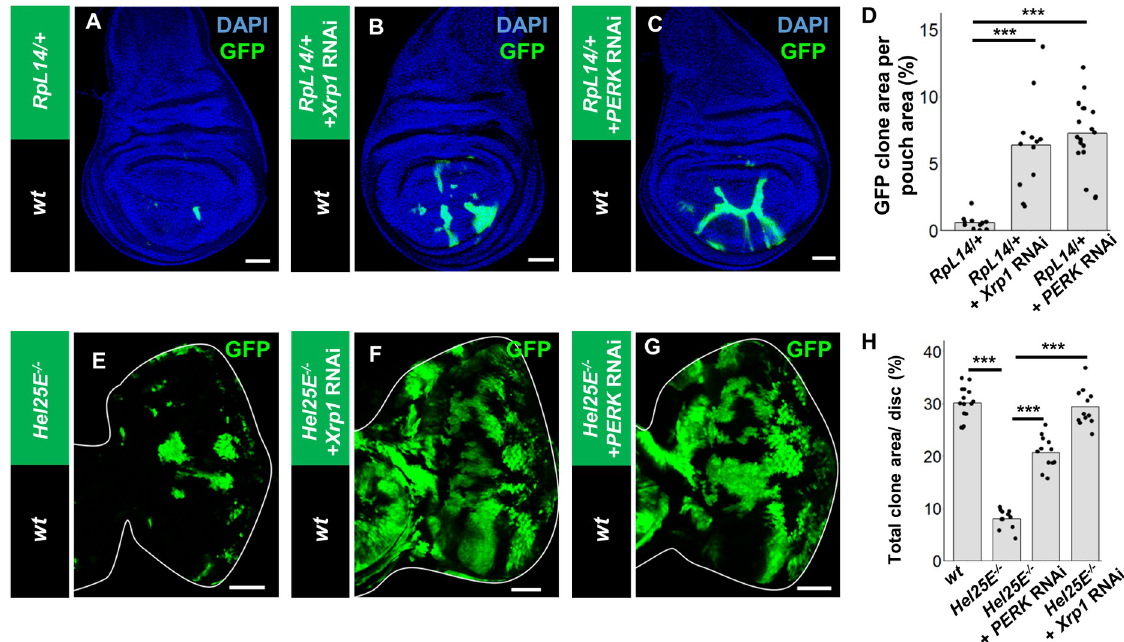
Fig 4. The Xrp1-PERK pathway is commonly required for cell competition. (A-C) Wing disc bearing hsFLP-induced GFP-labeled clones of RpL14/+ , salE > GFP (A), RpL14/+ , salE > GFP + Xrp1-RNAi (B), or RpL14/+ , salE > GFP + PERK-RNAi (C) cells. (D) Quantification of the relative size of GFP-labeled clones shown in A-C. Error bars, SD; ��� p < 0.001 by Dunnett test. (E-G) Eye disc bearing eyFLP-induced MARCM clones of Hel25E -/- (E), Hel25E -/- + Xrp1-RNAi (F), or Hel25E -/- + PERK-RNAi (G) cells. (H) Quantification of the relative size of GFP-labeled clones shown in E-G. Error bars, SD; ��� p < 0.001 by Steel-Dwass test. Scale bars, 50 μ m. See S1 Text for detailed genotypes.